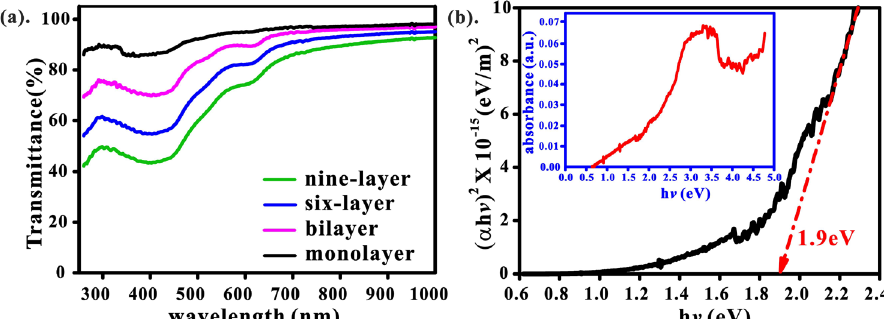
Figure 4. ( a ) Comparison of the transmittance of the WS 2 thin film with different thicknesses; ( b ) Tauc diagram of monolayer WS 2 from the absorption. Inset: the absorption measurement can be used to determine the band gap of WS 2 .